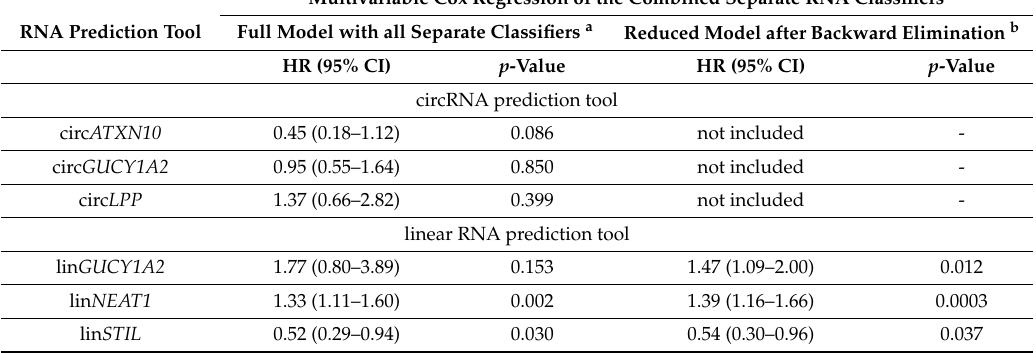
Table 7. Construction of a predictive RNA signature for biochemical recurrence based on Cox regression analysis, using a combination of the separate prediction tools for circRNAs and their linear counterparts. Multivariable Cox Regression of the Combined Separate RNA Classifiers RNA Prediction Tool Full Model with all Separate Classifiers a Reduced Model after Backward Elimination